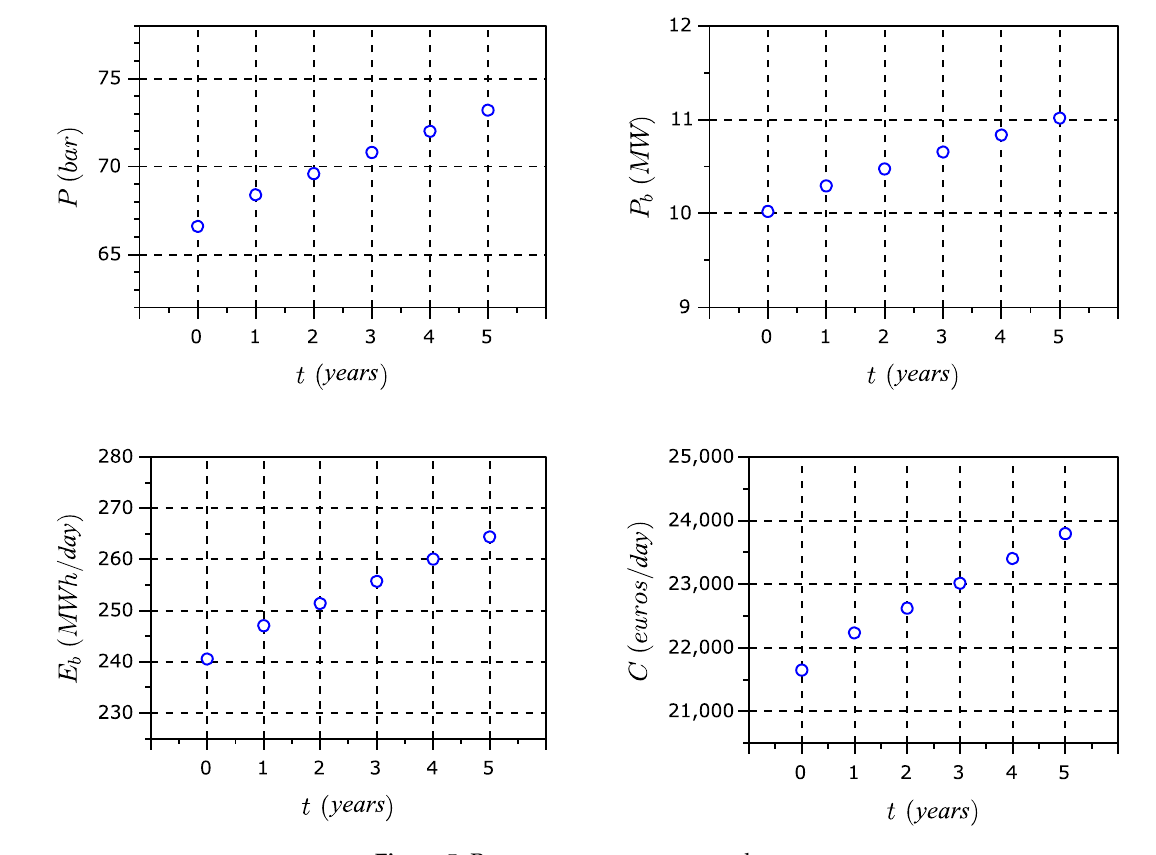
Figure 5. Pressure, power, energy and cost. Table 4. Pressure increases without membrane replacement at 17 °C.